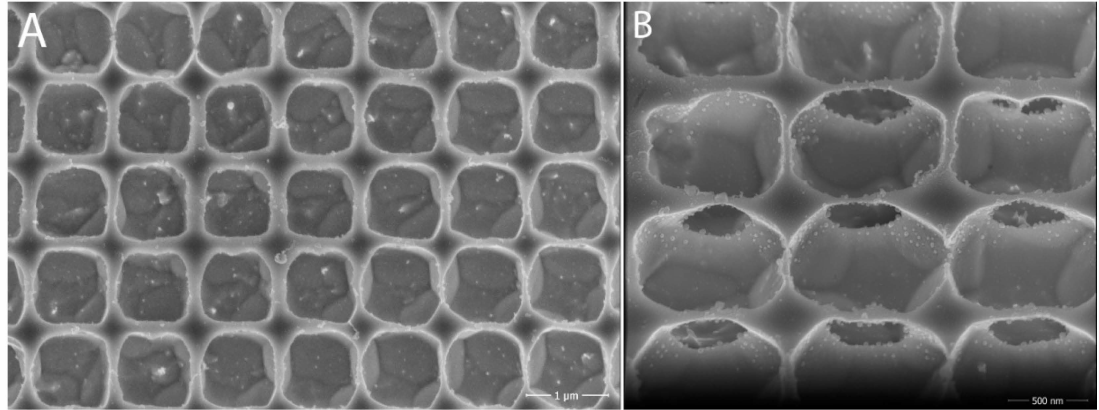
Figure 7. Lattice C2 under SEM microscope: ( A ) overall view; ( B ) zoomed view of irregularities and damage to the holes. Adapted from [15] with kind permission of Brno University of